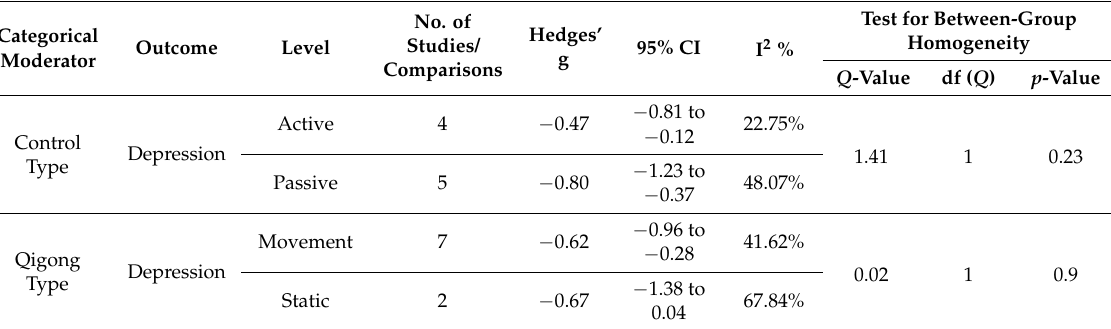
Table 2. Moderator analysis for Qigong versus control